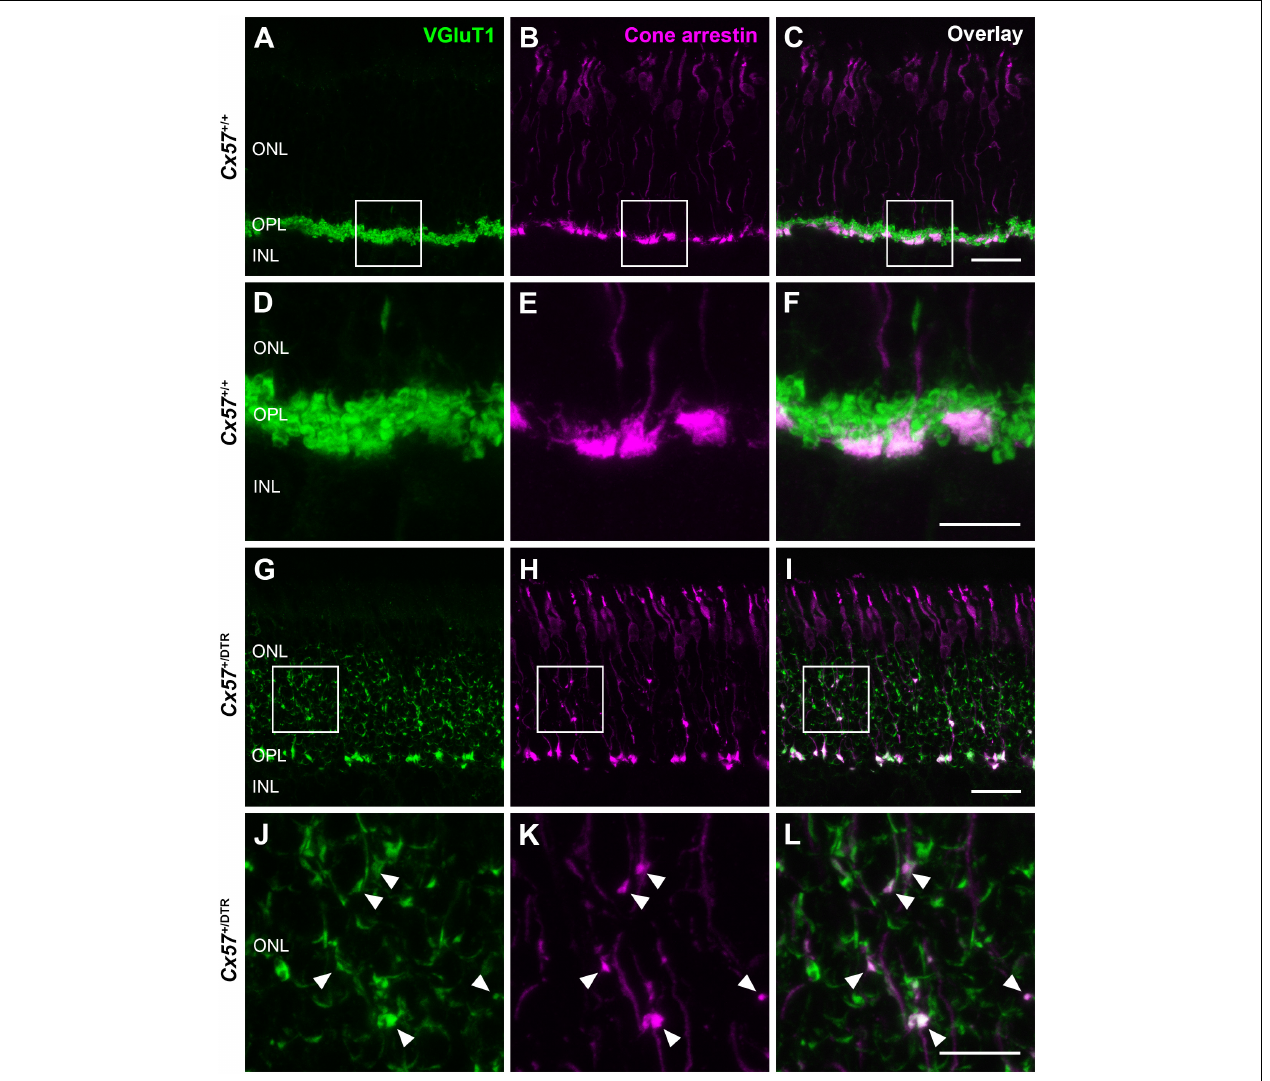
FIGURE 6 | New cone terminals express vesicular glutamate transporters. (A–L) Retinal cryosections of Cx57 + / + and Cx57 + / DTR mice (P56) were stained for the vesicular glutamate transporter VGluT1 (green) and cone arrestin (magenta). In wild-type and horizontal cell-ablated mice, cone pedicles in the OPL were VGluT1-positive (A–I) . Moreover, VGluT1 immunoreactivity was present within ectopic cone terminals in the ONL of Cx57 + / DTR mice (arrowheads) (J,K,L) . Scale bars, 25 µ m (C,I) , 10 µ m (F,L)